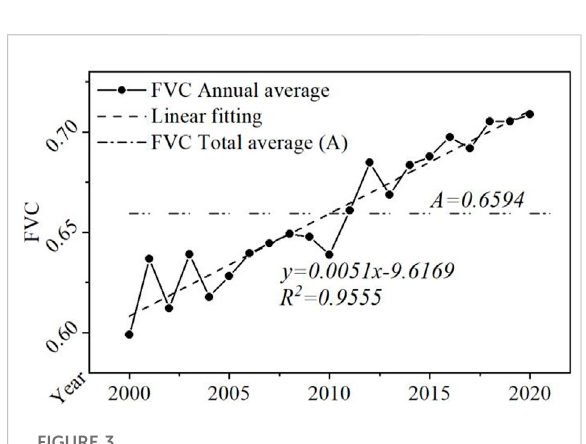
FIGURE 3 Interannual variation of FVC in the upper reaches of Ganjiang River Basin, China during the years 2000 –